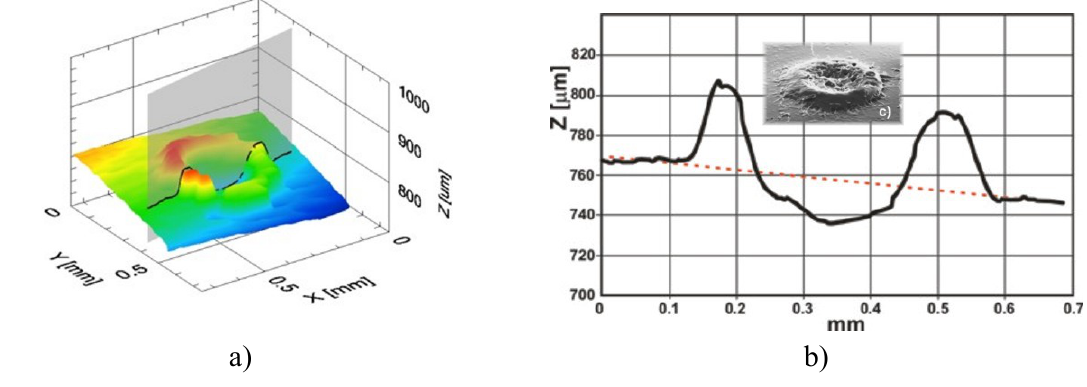
Figure 16. OCT analysis of Er:YAG ablation crater in varnish: a) recovery of shape; b) OCT measurement of the crater depth; c) SEM crater image – small photograph in b). In this case excessive laser energy density causes varnish